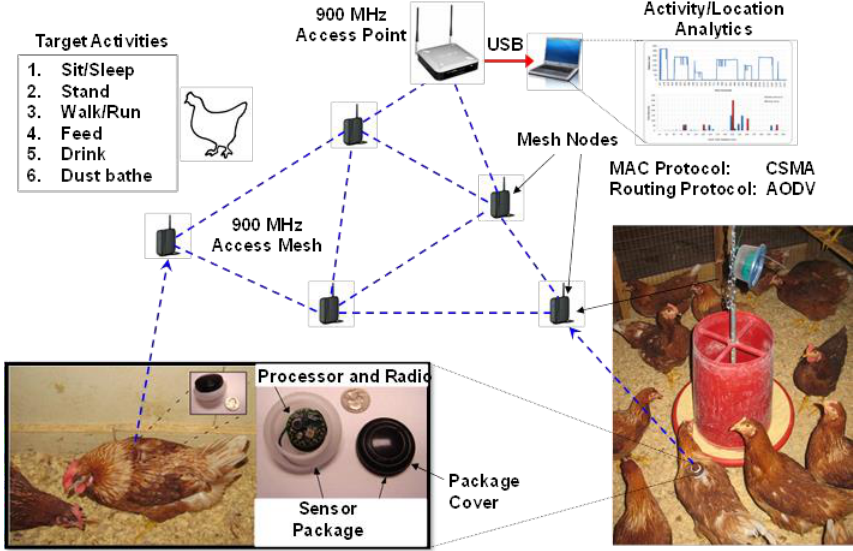
Figure 5. Arrangement of the various components within the body-worn RSSI sensor system. Hens wear small (10 g) sensors on their backs attached via a figure eight harness. These sensors actively transmit information to stationary receivers, which communicate with a base station. Activity and location analyses are then performed using analytical software to classify accelerometer data into specific behavioral activities and locations relative to other hens and the stationary receivers.